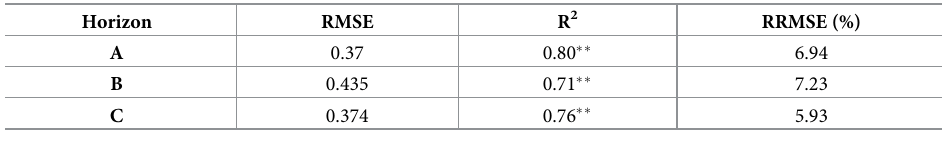
Table 5. Accuracy assessment indices of CART models in different horizons.